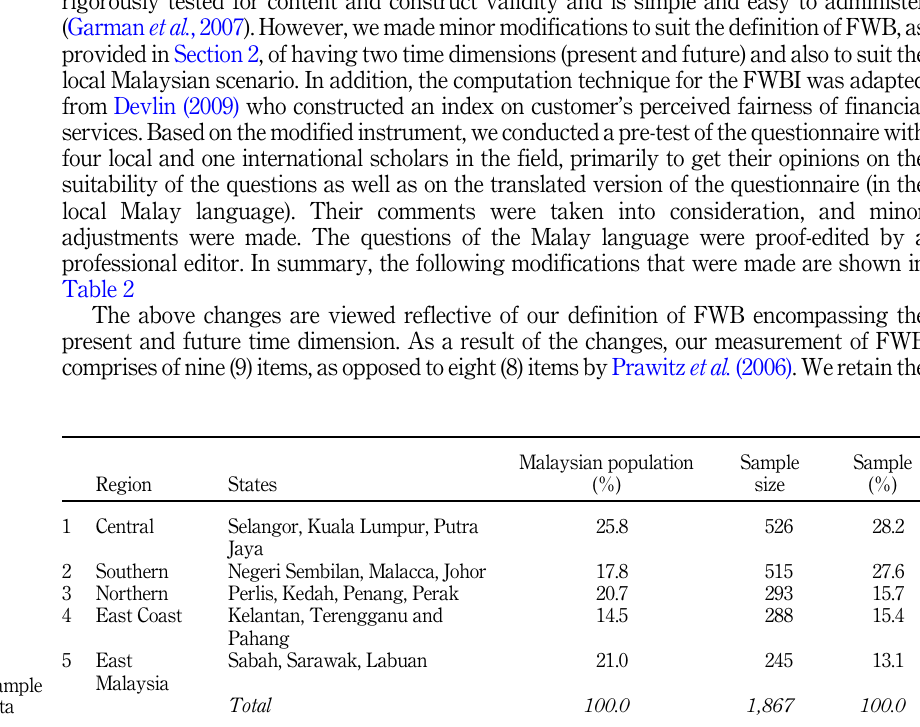
Table 1. Distribution of sample according to